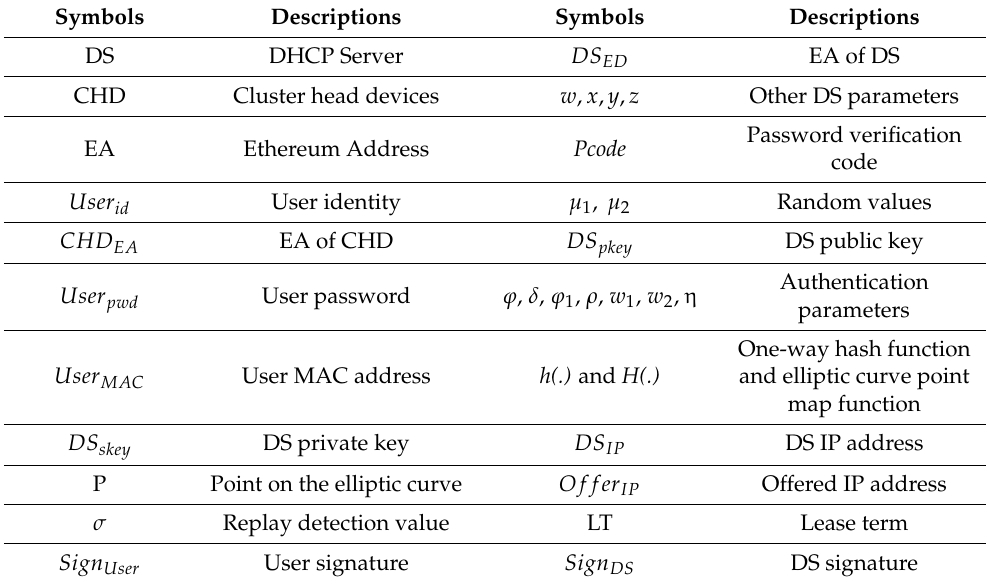
Table 2. Notations.